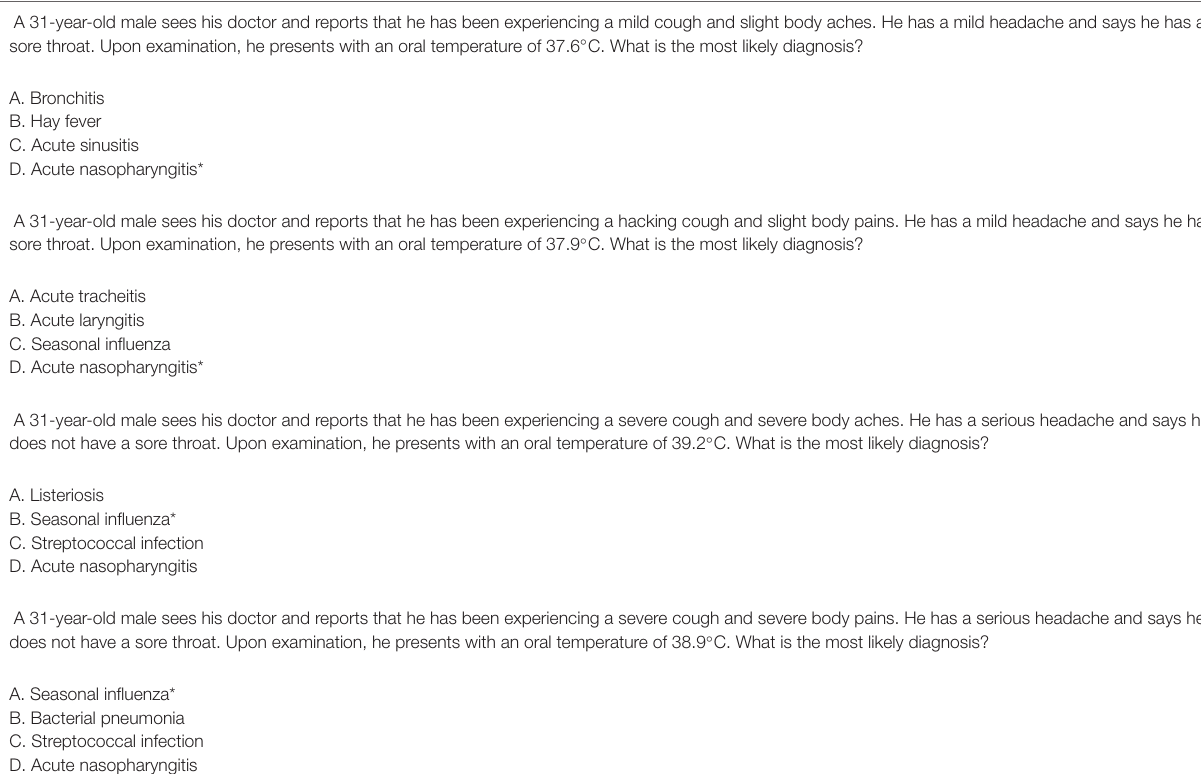
TABLE 2 | Sample of generated items from the medical